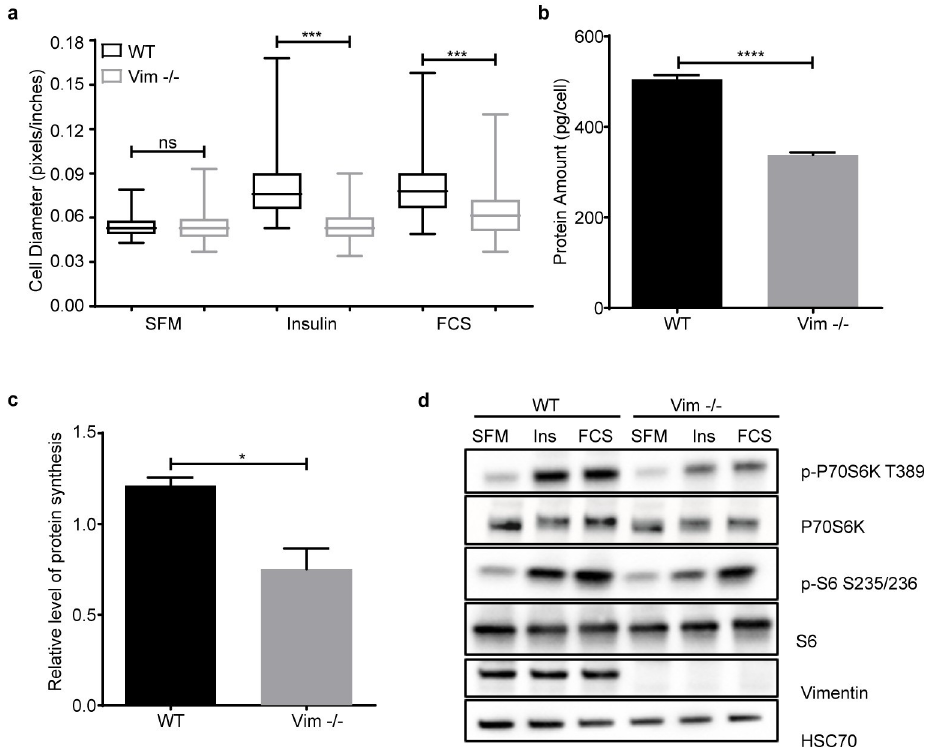
Fig 3. mTORC1 activation is impaired in Vim − / − MEFs. ( a ) Distribution of the cell diameter of WT and Vim − / − MEFs serum starved for 2 to 3 days and treated with 100 μ g/ml insulin or 5% FCS for 24 hours ( n = 3). ( b ) Protein amount per cell is represented as mean ± SEM of protein concentration. A same number of cells were lysed, and protein concentration was measured using a commercial BCA kit ( n = 3). ( c ) Protein synthesis is represented as mean ± SEM of WT and Vim − / − MEFs stimulated with insulin for 30 minutes and it was measured by using the Click-iT HPG Alexa Fluor Protein Synthesis Assay Kit ( n = 3). Protein synthesis was quantified using the mean fluorescence intensity normalized to the serum-starved treatment. ( d ) Western blotting analysis of serum-starved cells (overnight) treated with 100 nM of insulin or 5% serum for 15 minutes ( n = 3). � p < 0.05, ��� p < 0.001, ���� p < 0.0001, ns = nonsignificant. The data underlying the graphs shown in Fig 3A–3C can be found in S1 Data. SFM, serum-free media; FCS, fetal calf serum; mTORC1, mechanistic target of rapamycin kinase complex 1.